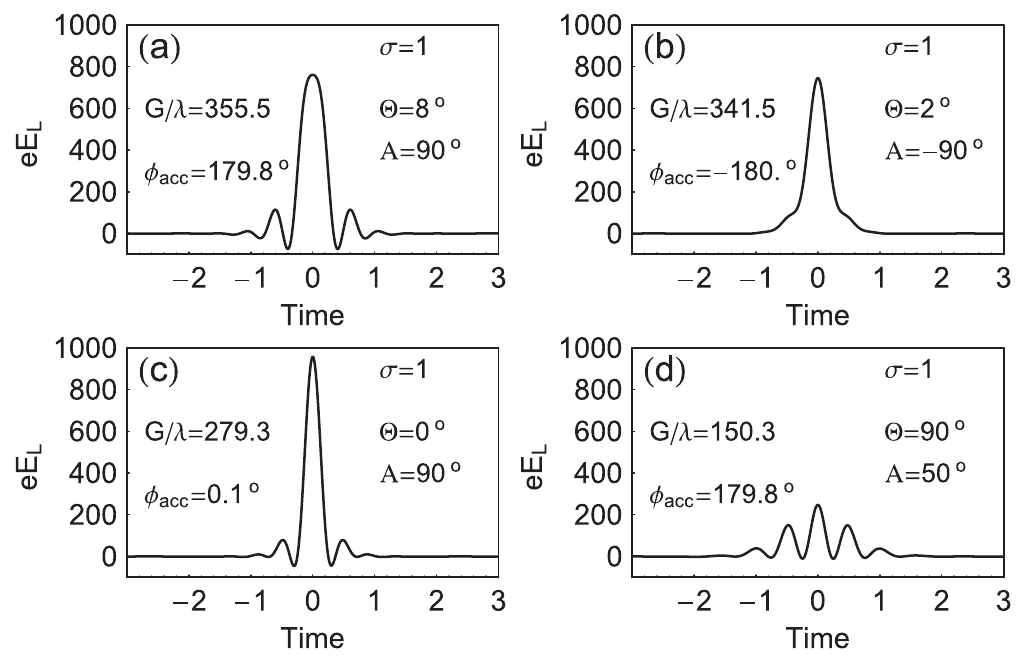
FIG. 7. The accelerating electric field as a function of time for several characteristic trajectories and the corresponding acceleration are given for particles for which the point of the closest approach lies on the meridian (cid:4) (cid:2) 0 . phases. The acceleration phases (cid:6) acc Parts (a), (b), and (c) correspond to electron trajectories passing the polar regions where energy gains are highest. Part (d) corresponds to an electron passing across the equatorial plain (cid:3) (cid:2) 90 (cid:14) . This case is similar to that of the electron moving near a dielectric cylinder at WGM resonance, discussed in